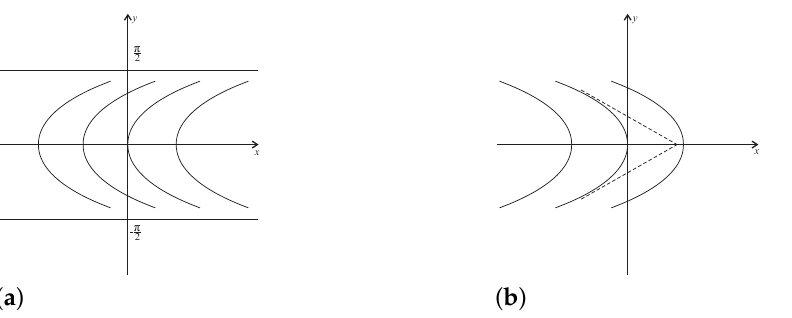
Figure 2. ( a ) The turn of a flow in the strip. ( b ) The turn of a flow on the plane with